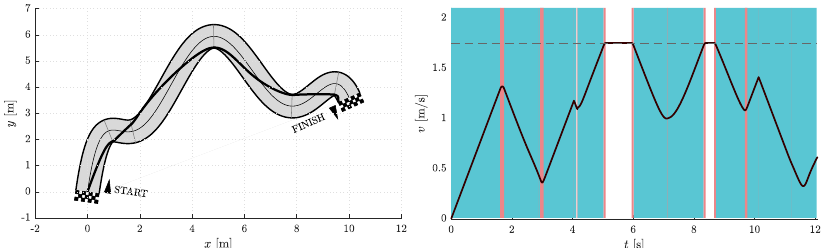
Figure 10. Resulting path as optimization result for N free = 2 and N seg = 3 ( left ) with the corre- sponding velocity profile ( right ). Blue vertical bands indicate intervals where the acceleration reaches its maximum allowable values. Similarly, red vertical bands indicate intervals where the jerk reaches its maximum allowable value.